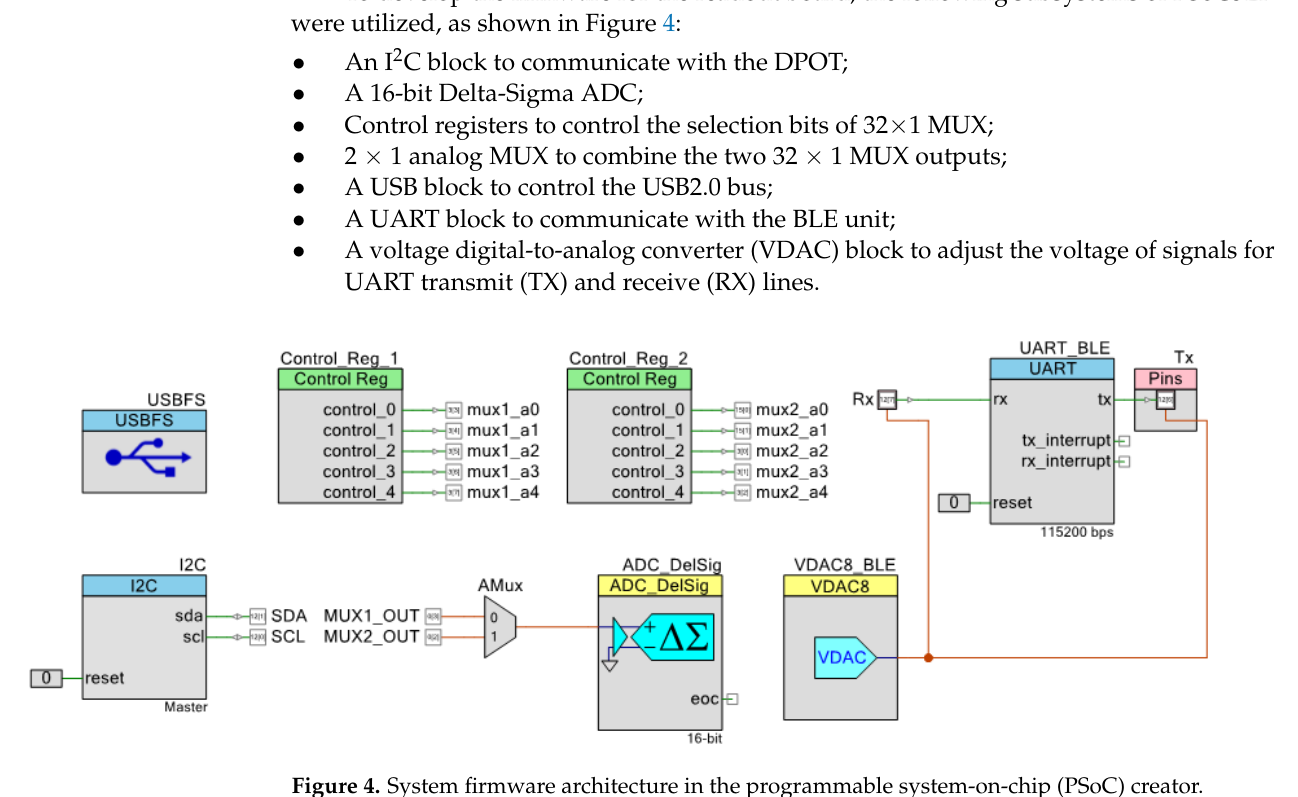
Figure 4. System firmware architecture in the programmable system-on-chip (PSoC) creator.